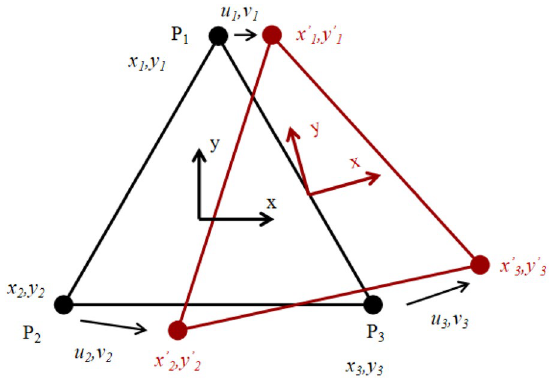
Figure 1. Calculation principle of digital image correlation